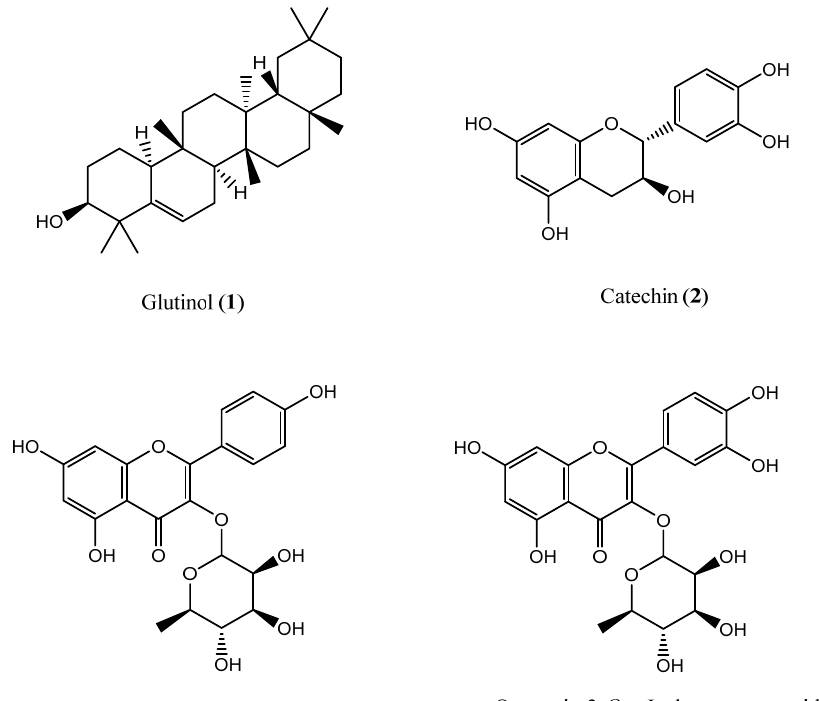
Figure 1. Chemical structures of secondary metabolites isolated from the methanolic extract of aerial parts of E. cactus (ECME).